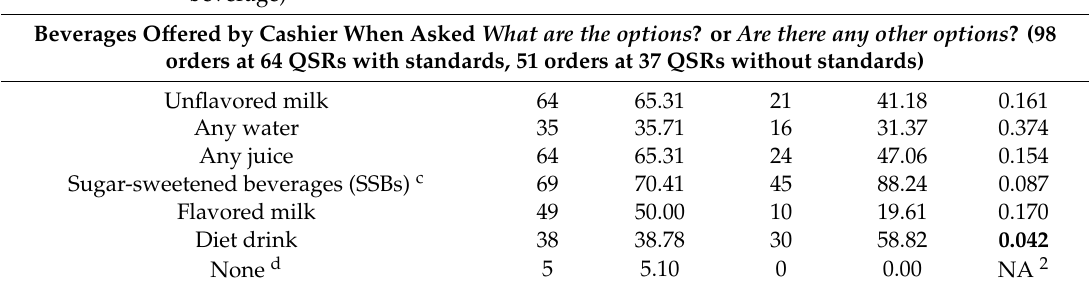
Orders at QSRs Orders at QSRs with Standards a without Standards a p -Value 1 n % n